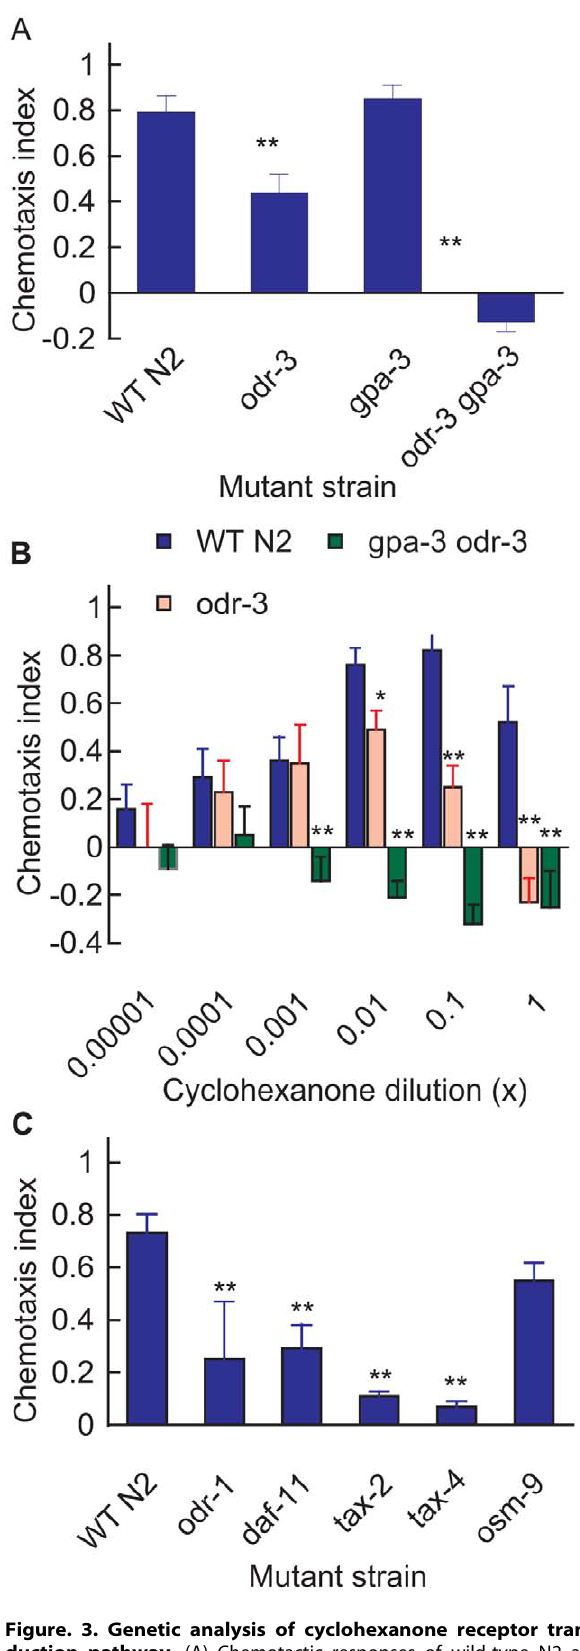
Figure. 3. Genetic analysis of cyclohexanone receptor trans- duction pathway. (A) Chemotactic responses of wild-type N2 and mutants defective in one or more G a subunits: odr-3(n2150),